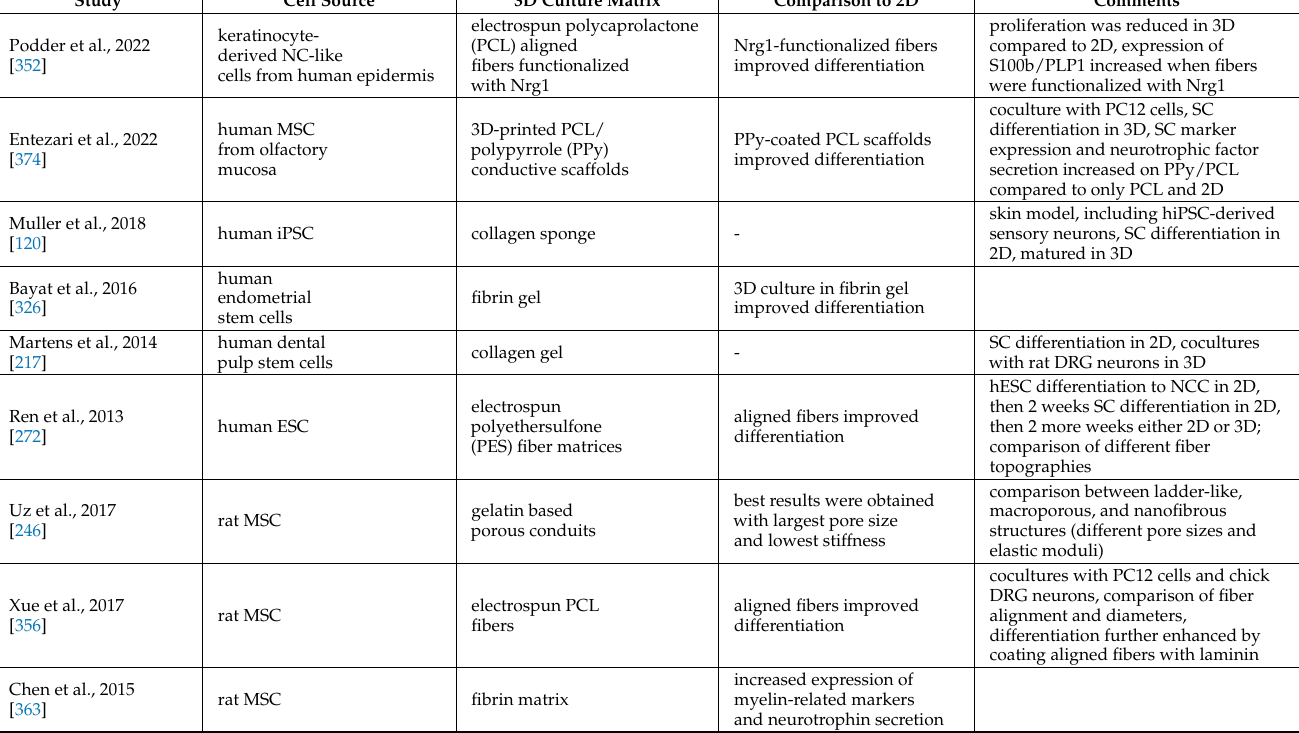
Table 5. Examples for Schwann cell differentiation in 3D cultures. Sorted from most to least